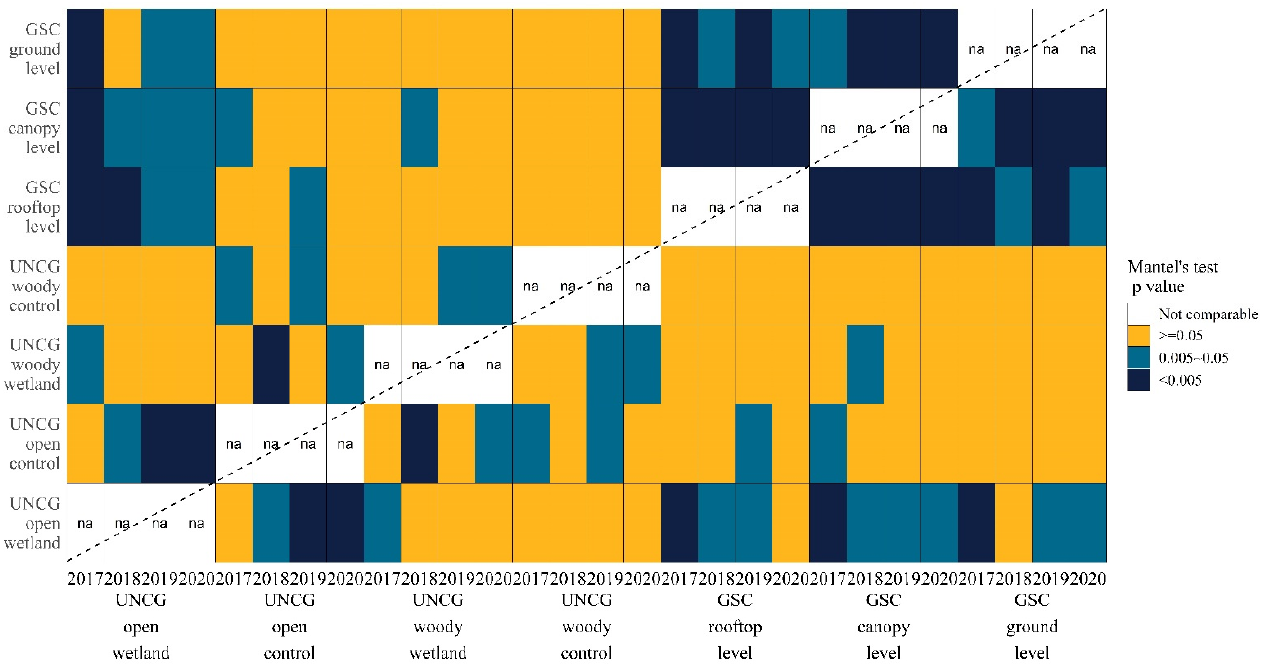
Figure 4. Correlogram showing community composition comparison among study sites in Greensboro, NC, USA. Mantel’s tests were used to compare sites. A p value smaller than 0.05 (shown in light and dark blue) indicated two sites were significantly correlated and had no compositional difference whereas a p value larger than 0.05 (shown in yellow) indicated two communities being different.